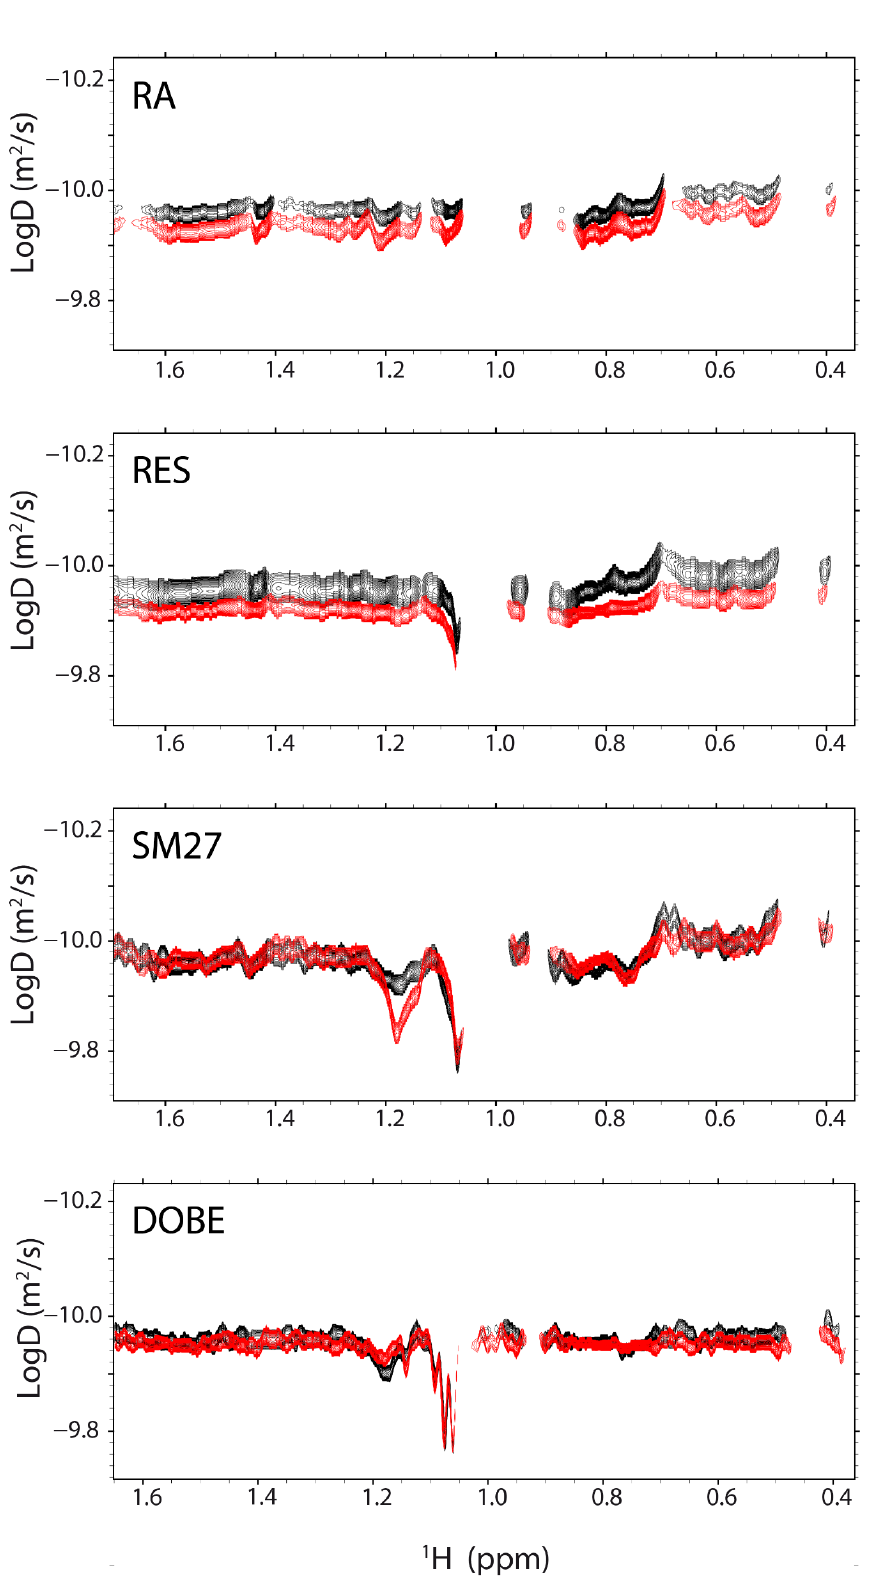
Figure 4. Overlay of 2D NMR DOSY spectra of the FGF2/D2 complex ([FGF2] = [D2] = 0.2 mM) (black) and FGF2/D2 in the presence of the library molecules (red, FGF2:D2:small molecule 1:1:4). In each panel, the DOSY recorded on the freshly prepared FGF2/D2 twin samples (with and with-out ligand) are shown. The employed library molecule is indicated in the upper-left corner of each